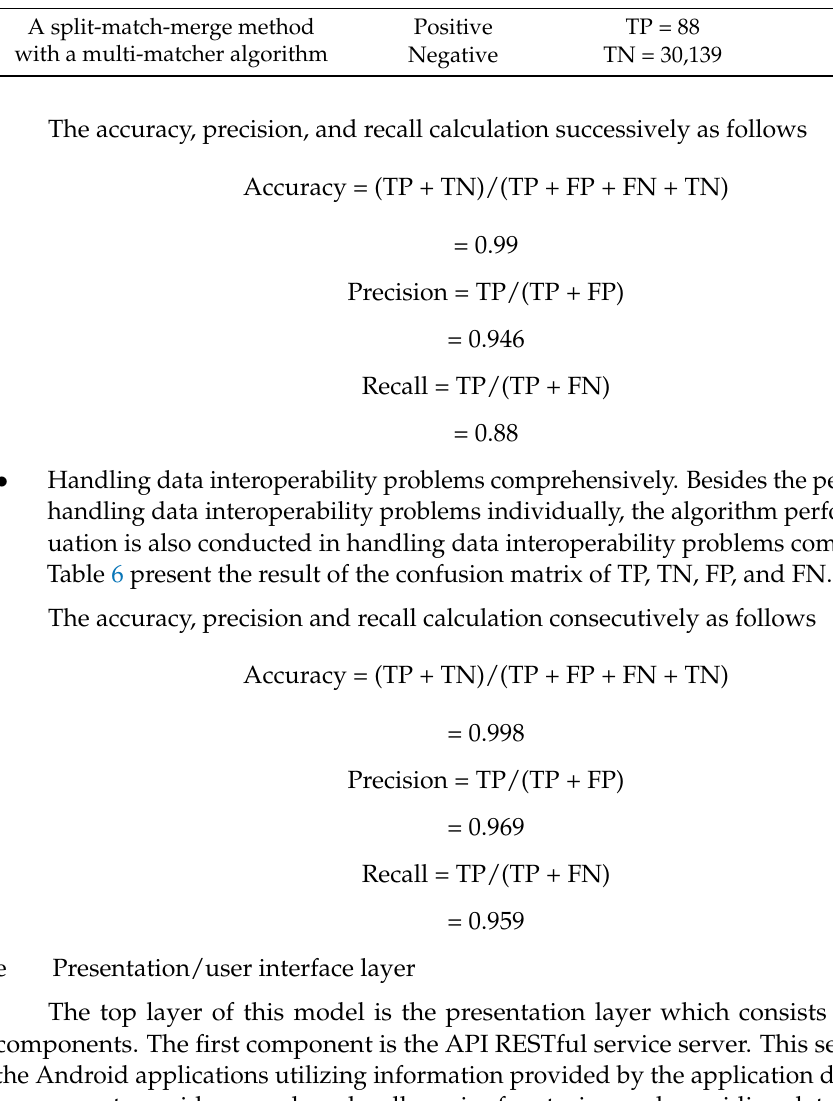
Table 7. Calculation TP, TN, FP, FN in handling schema granularity problem. A split-match-merge method with a multi-matcher algorithm